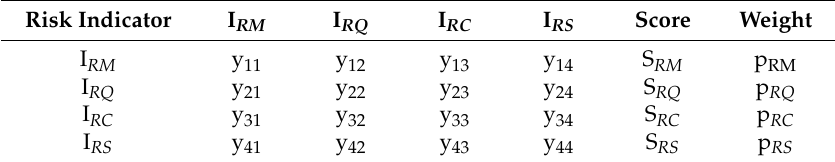
Table 9. Determination of the weighting coefficients for risk